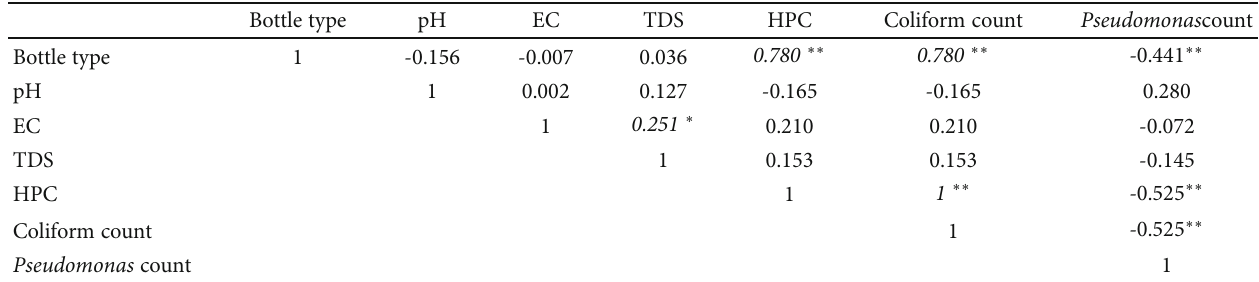
Table 2: Correlation between physical parameters and microbiological